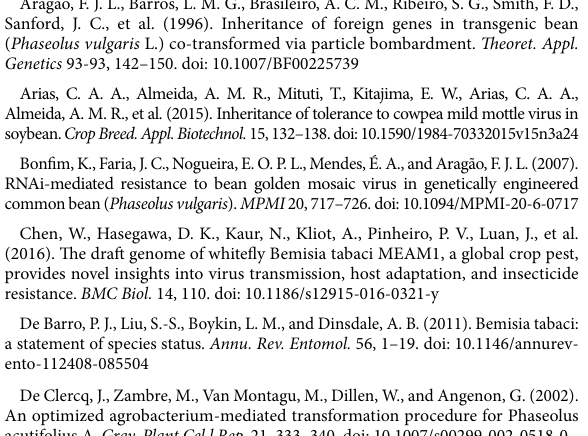
SUPPLEMENTARY TABLE S1 Agronomic traits of the transgenic common bean line 22.5 and the non- transgenic control